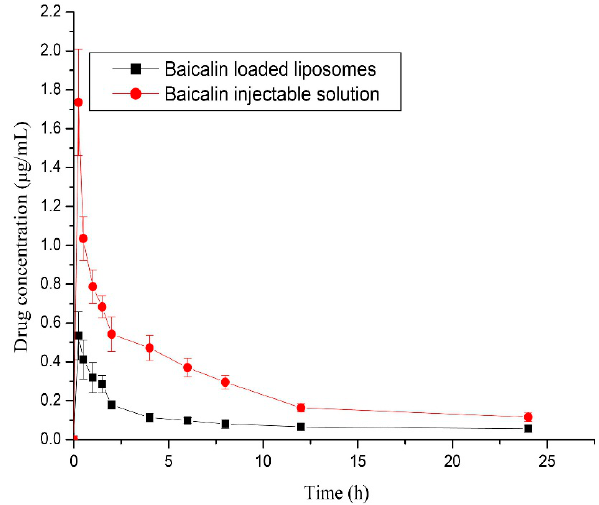
Figure 10. Mean plasma drug concentration-time profile of baicalin determined by LC-UV method via intravenous administration of baicalin loaded liposomes and its injectable solution at a dose of 10 mg/kg to rabbits. Each point represents the mean + SD ( n = 5). Table 5. The comparative pharmacokinetic parameters via intravenous administration of baicalin loaded liposomes and its injectable solution at a dose of 10 mg/kg to rabbits. Each point represents the mean + SD ( n = 5).